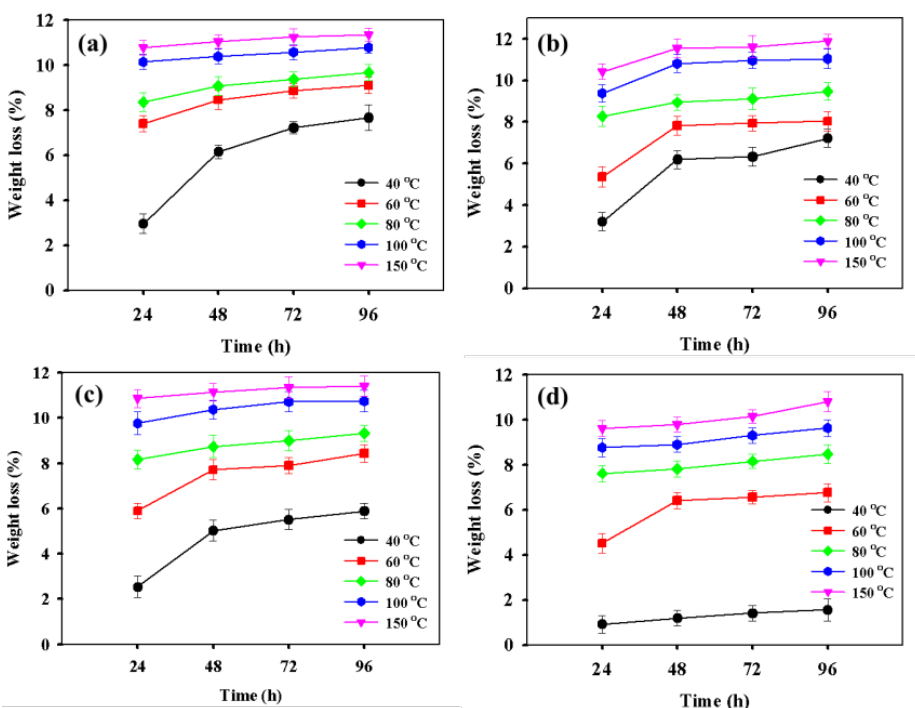
Figure 6. Weight loss data of PULL/TOCNs-based composite film with varying CNT contents of ( a ) 0.5%, ( b ) 1%, ( c ) 3%, and ( d ) 5%.